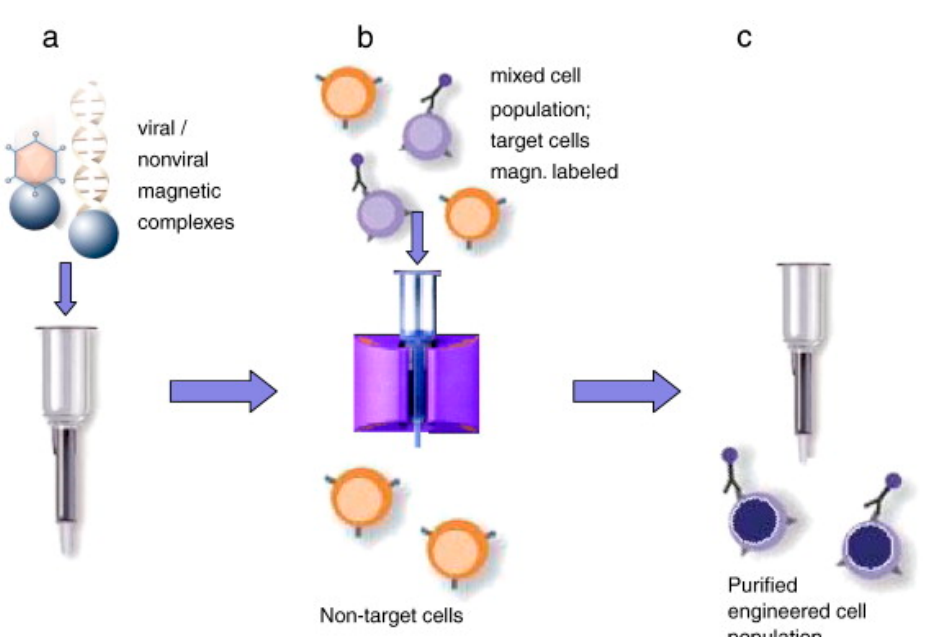
Figure 25. Magselectofection. ( a ) A cell sorting column activated magnetically is loaded with magnetic vectors. ( b ) A high gradient magnetic field is used to associate magnetically activated cells with magnetic vectors. ( c ) The cell sorting device is withdrawn from the magnetic field and selected cells are pushed out from the device. Reprinted with permission from ref. [159]. Copyright © 2011 Elsevier.